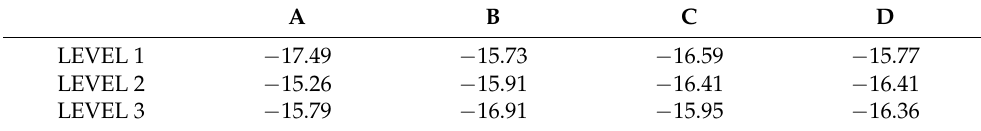
Table 15. ANOVA analysis (CAE-1024). A B C D LEVEL